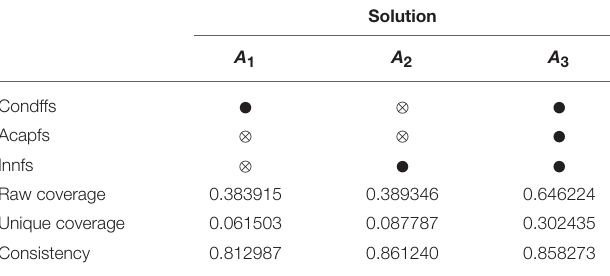
TABLE 9 | Configurations for achieving a good organizational